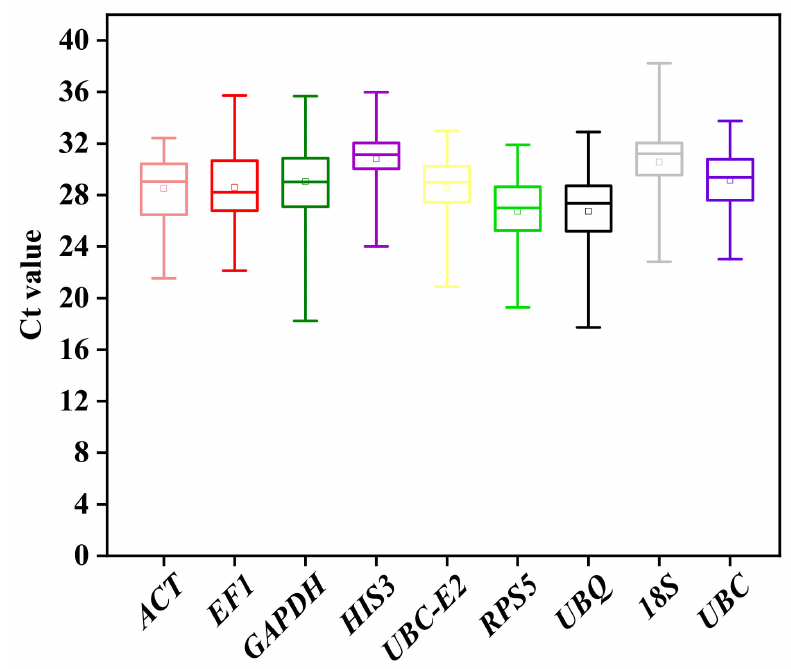
Figure 3. Distribution of Ct values of the nine candidate reference genes in garlic among all the tested samples. The boxes indicate the 25th and 75th percentiles. The line across the box and the inner square in each box indicate the median and mean Ct values,